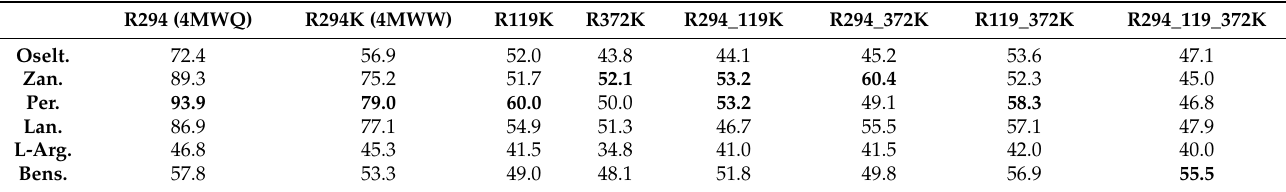
Table 1. Lowest binding energies according to AutoDock software 1 . Table 2. ChemPLP scores according to GOLD software 1 .